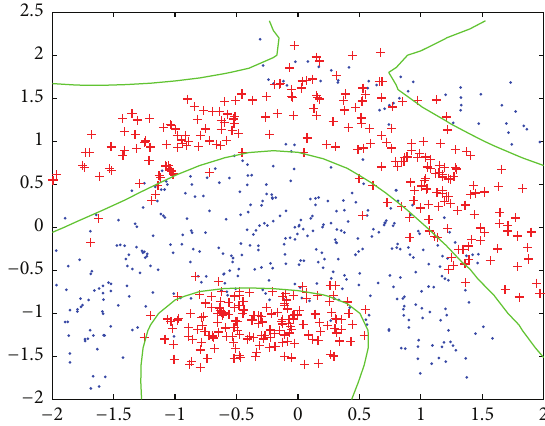
Figure 9: The boundaries of Tri-H KELM algorithms in Banana